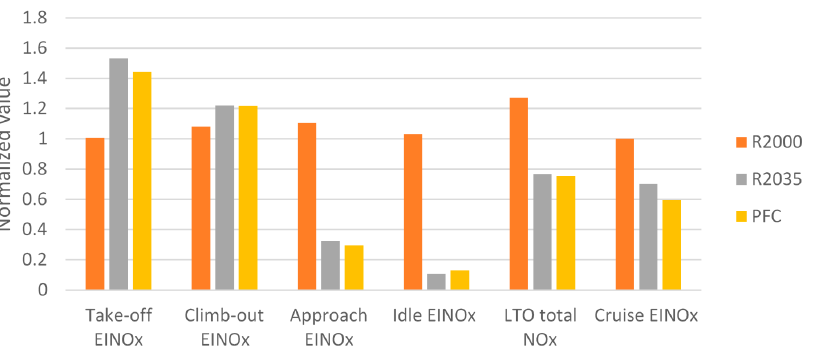
Figure 38. NO x emissions assessments results for the CENTRELINE R2000, R2035 & PFC aircraft.